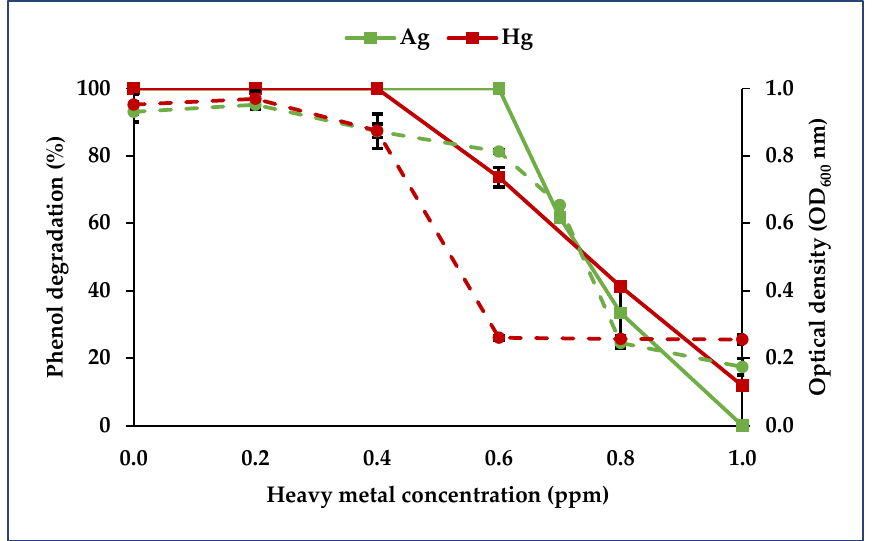
Figure 5. Effects of exposure to different concentrations of Ag and Hg on phenol degradation (solid line) and growth (dotted line) of Arthrobacter sp. strain AQ5-06. Error bars represent the mean ± standard deviation of three replicates.